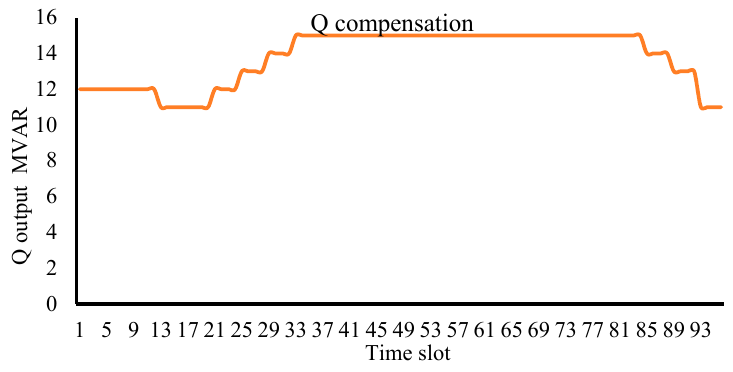
Figure 12. Reactive power output of the compensator.